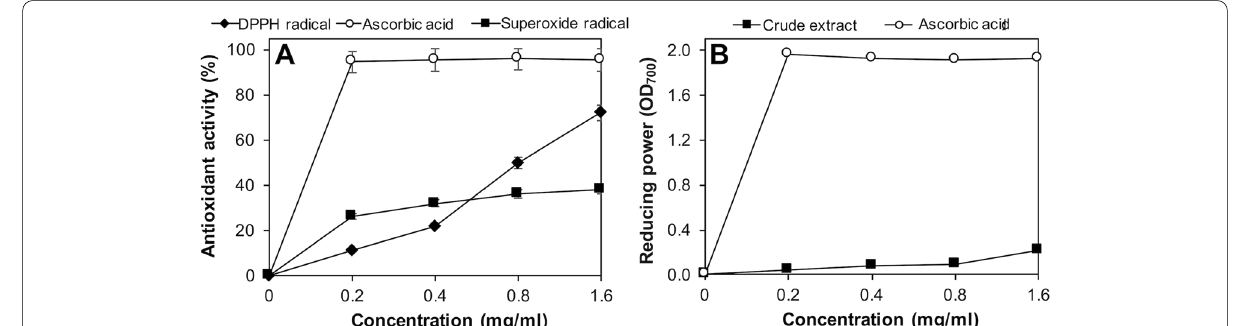
Fig. 1 Antioxidant activities including DPPH and superoxide radical scavenging activities ( A ) and reducing power ( B ) determined in the VCCM 22513